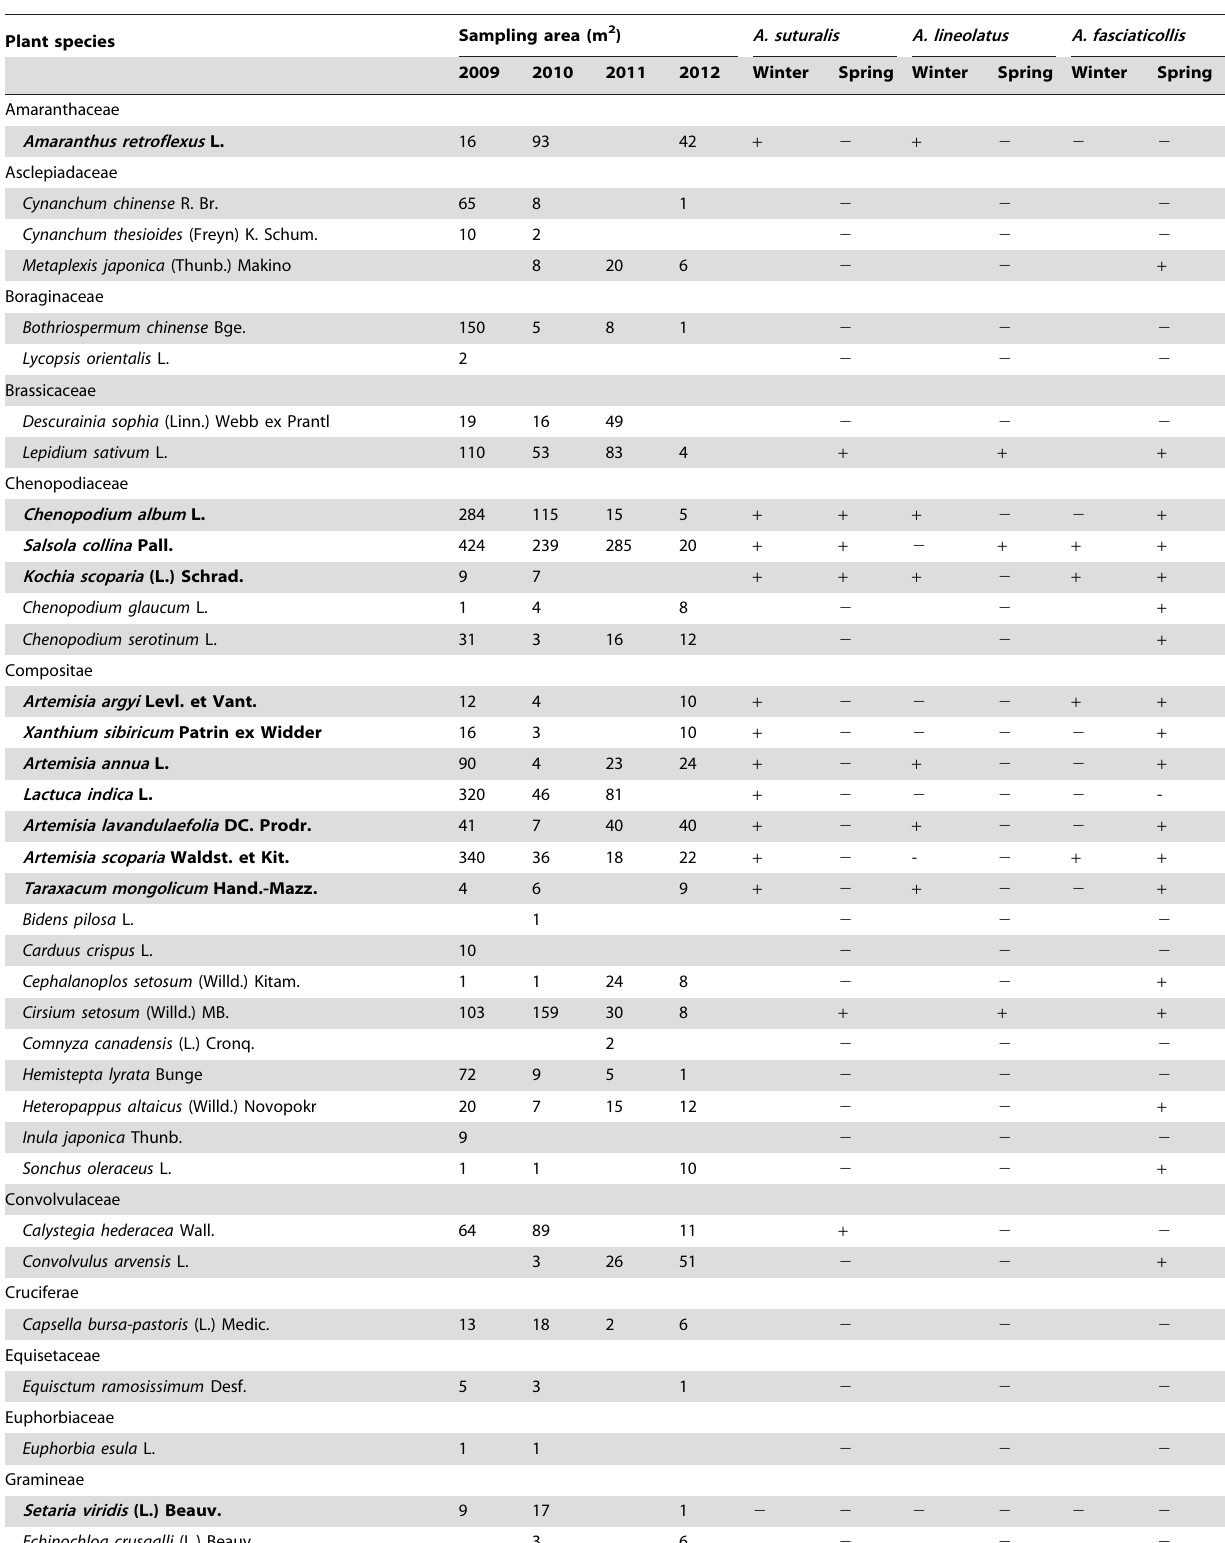
Table 1. Weedy host plants of Adelphocoris spp. in the spring and the winter during 2009–2012 at Langfang, Hebei Province,